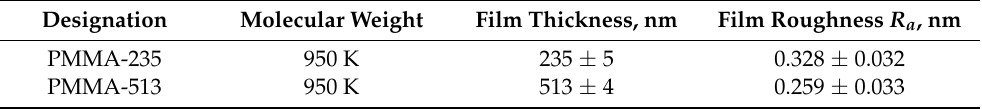
Table 1. Characterization of PMMA